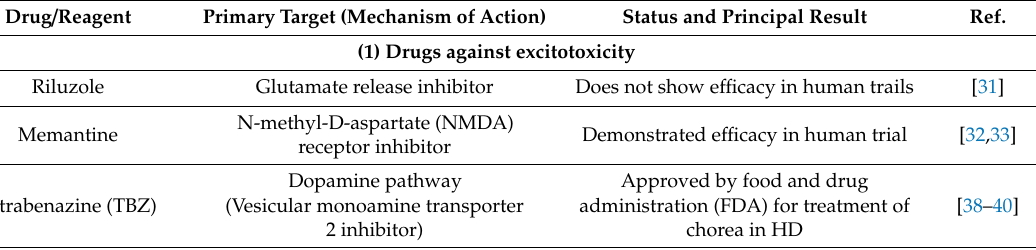
Table 1. Recent status of Huntington’s disease (HD) drug